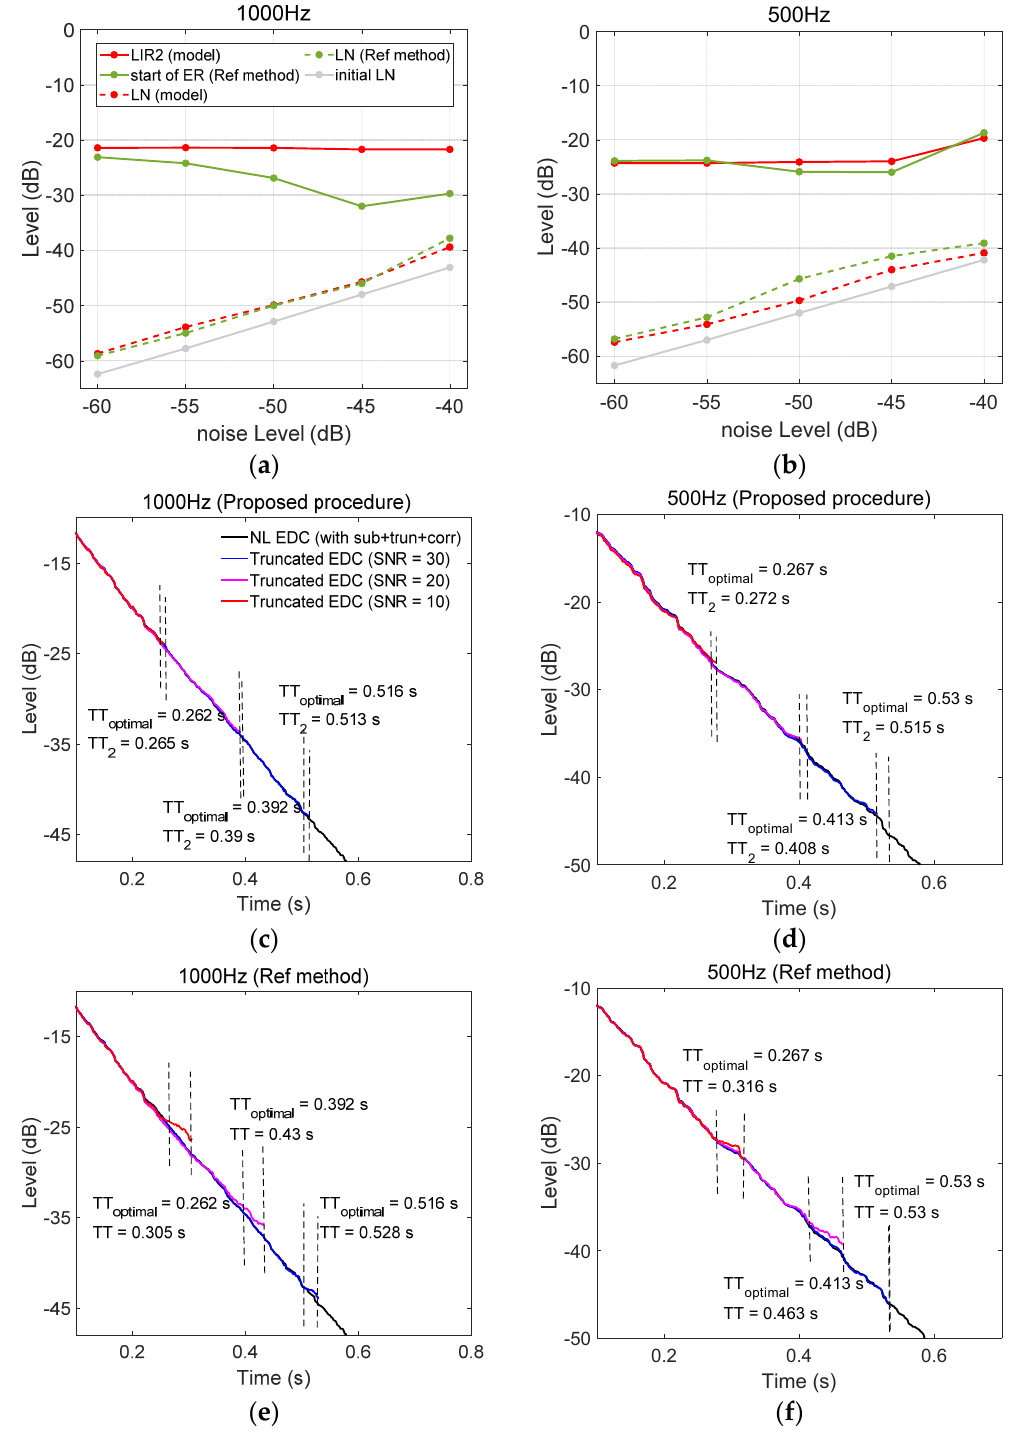
Figure 6. Comparison of the results of the proposed procedure and the reference method with added pink noise ( − 60 dB to − 40 dB) and band-pass filtering at the 1 kHz and 500 Hz: ( a , b ) The proposed procedure gives more stable parameters of LIR 2 and LN . ( c , d ) Comparison of the truncated EDCs of the proposed procedure using the parameters in ( a , b ) from the reference NL EDC with the TT 2 and € ( e , f ) Comparison of the truncated EDCs of the reference procedure using the parameters in ( a , b ) from the reference NL EDC with the TT 2 and TT opimal